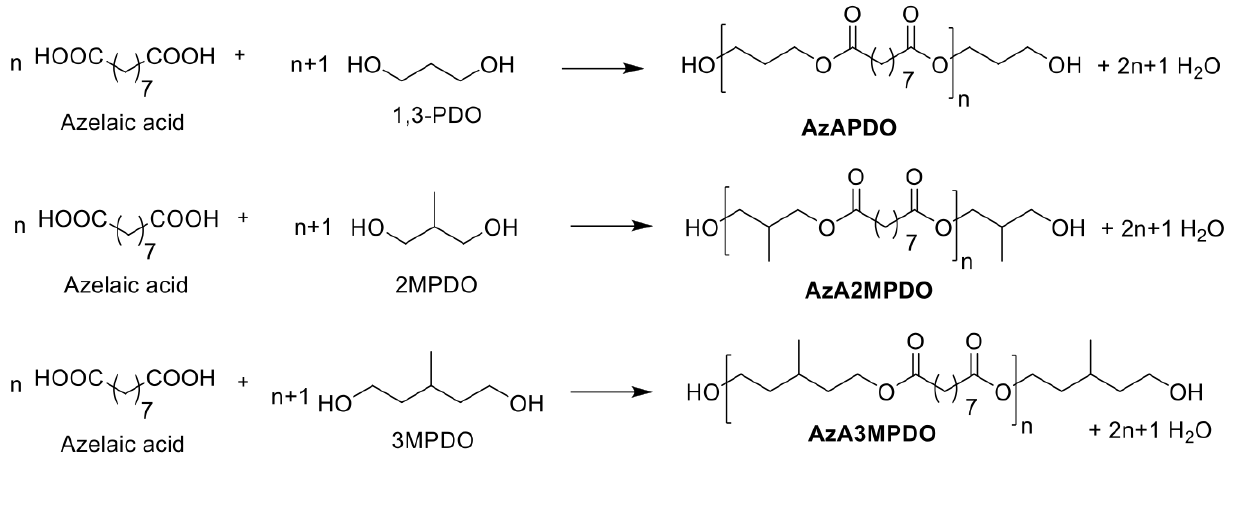
Scheme 1. Synthesis of polyester